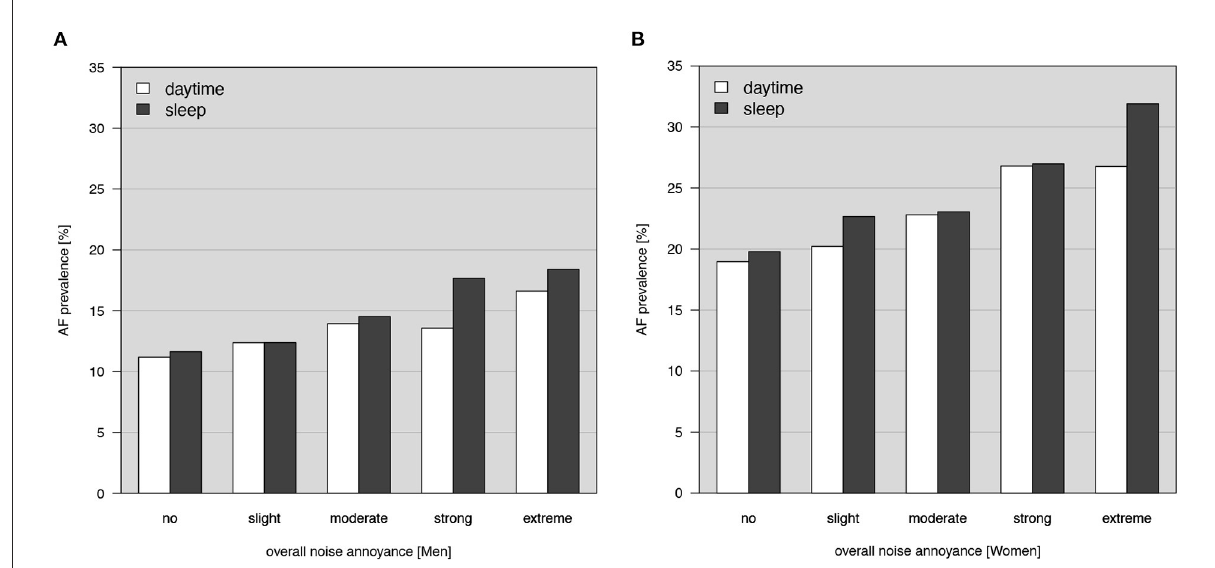
FIGURE1 Prevalence of atrial fibrillation (AF) in relation to the degree of overall noise annoyance stratified by daytime or sleep in (A) men and (B)